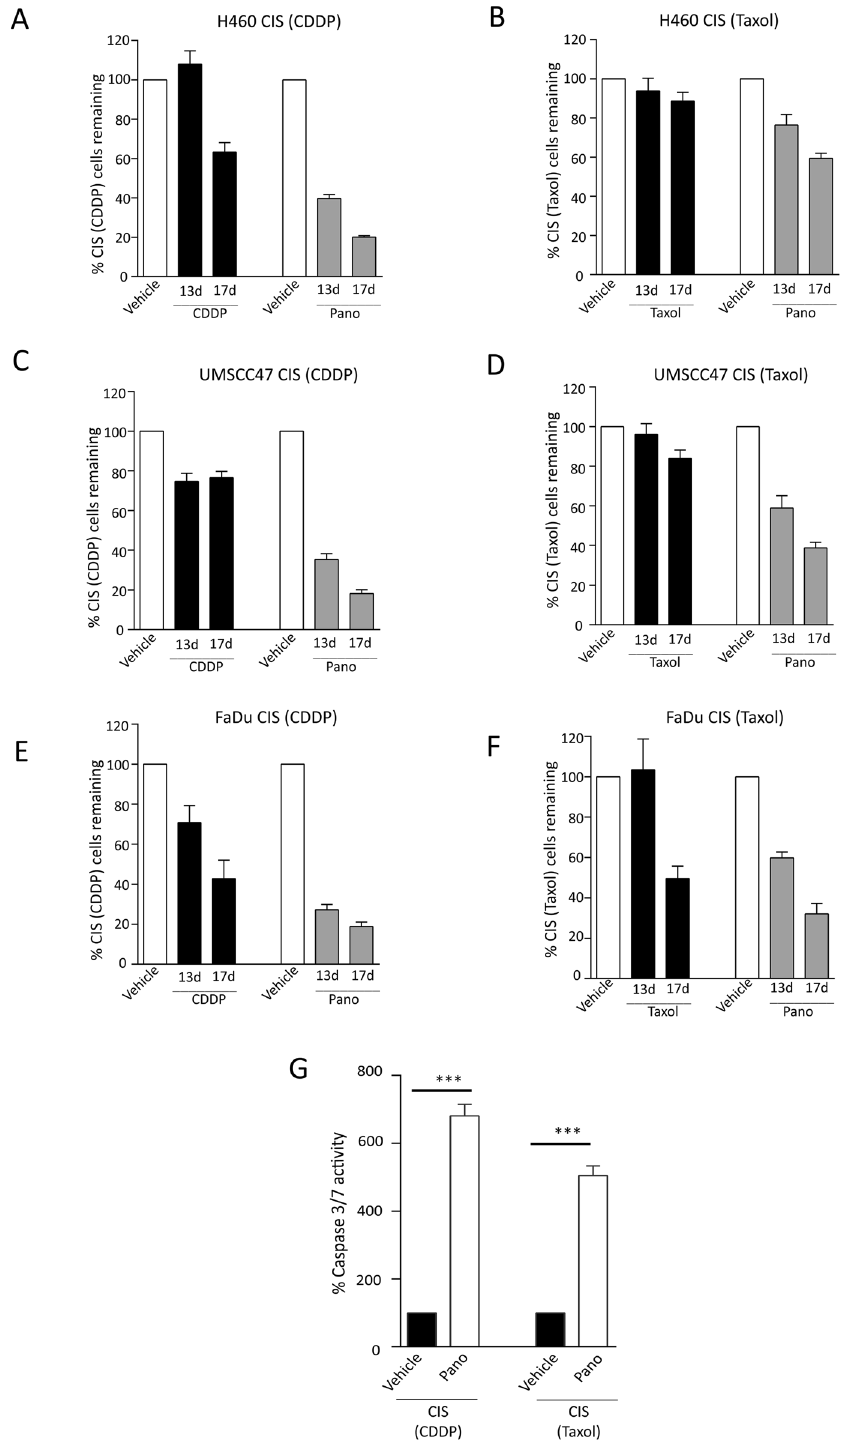
Figure 5. Pano has Senolytic Activity in Other Chemotherapy-Induced Senescent NSCLC and HNSCC Cells. Quantitative analysis of SRB-stained adherent CIS cells at 13 and 17 days post treatment indicating significant pano-mediated cell loss, relative to chemotherapy, in ( A ) H460 CIS (CDDP) ( B ) H460 CIS (Taxol) ( C ) UMSCC47 CIS (CDDP) ( D ) UMSCC47 CIS (Taxol) ( E ) FaDu CIS (CDDP) and ( F ) FaDu CIS (Taxol) cells. The same experimental design outlined in schema Fig. 4A was utilized. Bar represents mean ± SEM ( n = 6). An unpaired t -test of pano versus chemotherapy at day 17 indicate a statistically significant difference in ( A–D ) ( P < 0.0001); and ( P < 0.001) in FaDu, ( E and F ). ( G ) Increased caspase 3/7 activity in pano-treated (3 days) CIS populations of H460 cells. Bar represents mean ± SEM ( n = 3). P = < 0.05: unpaired t -test of pano versus vehicle for both CIS (CDDP and Taxol